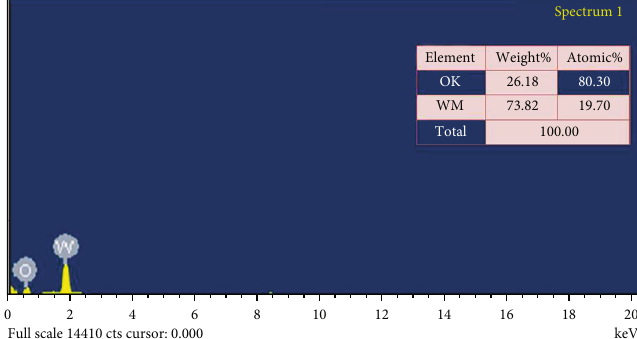
Figure 7: EDX image of prepared WO